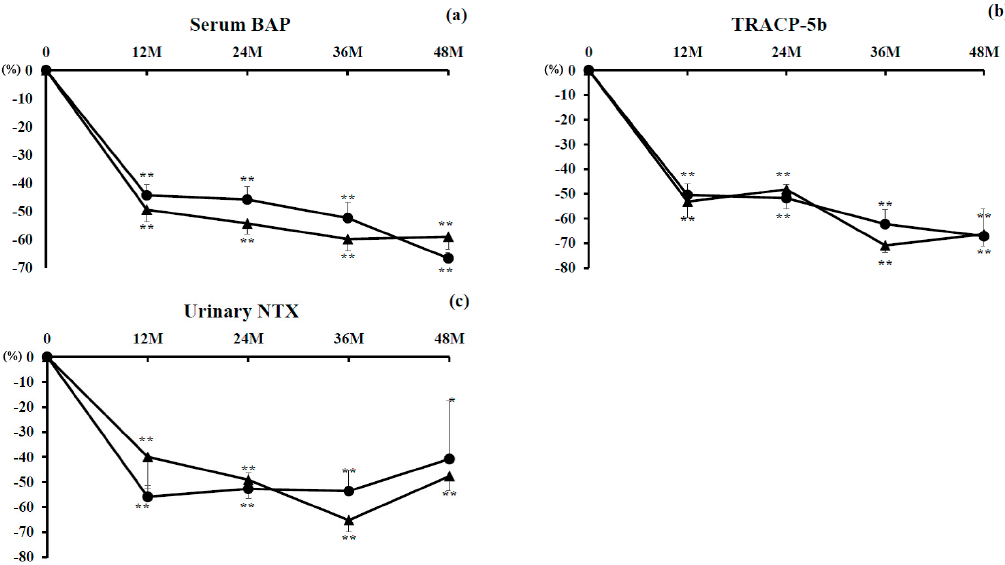
Figure 2. Percent changes in concentrations of bone alkaline phosphatase (BAP) ( a ) and tartrate-resistant acid phosphatase (TRACP)-5b ( b ) and of urinary N-terminal telopeptide of type-I collagen (NTX) ( c ). Closed circles indicate the denosumab monotherapy group and closed triangles indicate the combination group. Single ( P < 0.05) and double ( P < 0.01) asterisks denote significant differences compared with pretreatment values.